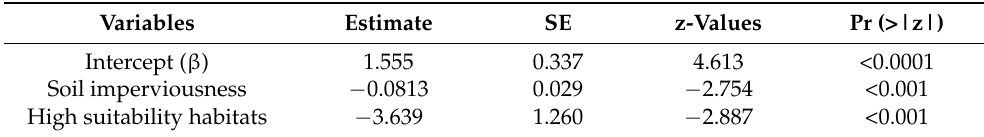
Table 3. Model estimates and significance of environmental variables for the extinction of Spermophilus citellus colonies. Variables Estimate SE z-Values Pr (>|z|) Intercept ( β ) 1.555 0.337 4.613 <0.0001 Soil imperviousness − 0.0813 0.029 − 2.754 <0.001 High suitability habitats − 3.639 1.260 − 2.887